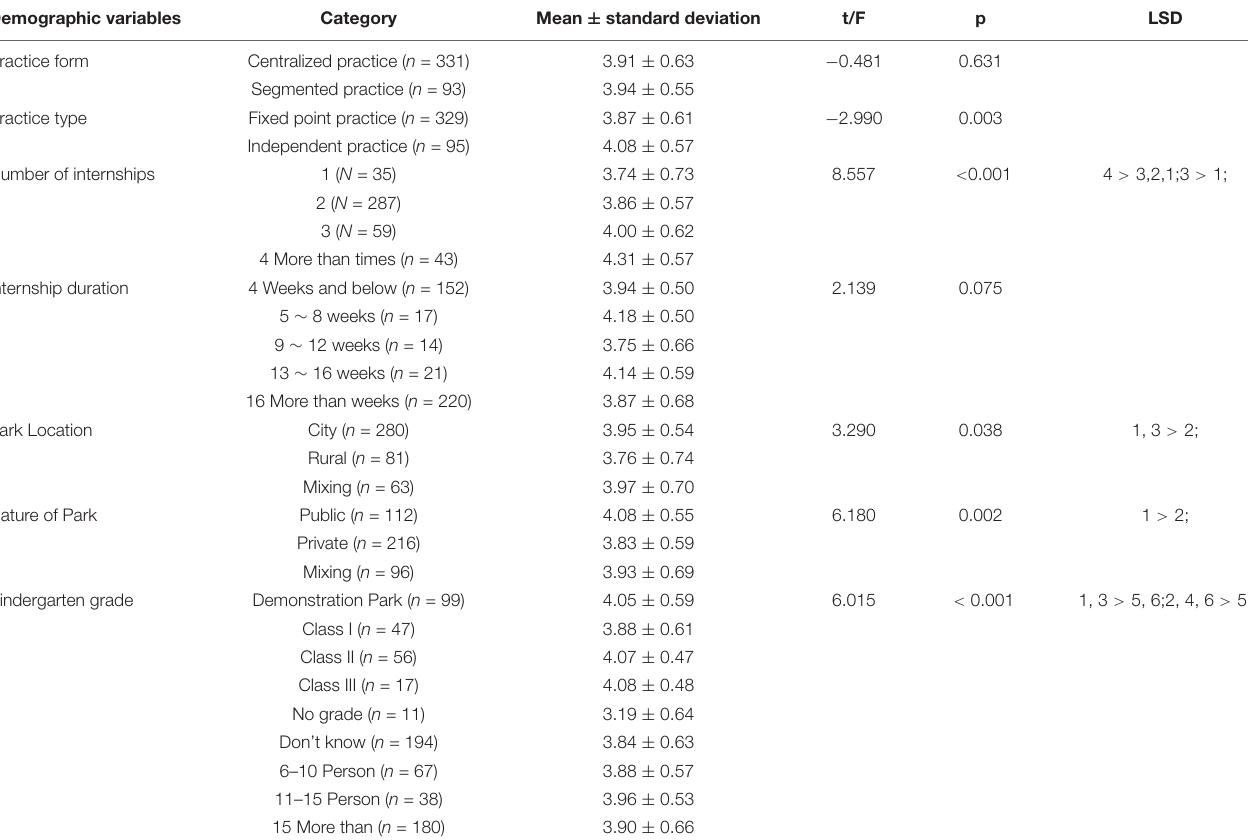
TABLE 8 | Difference in test results of demographic variables in each